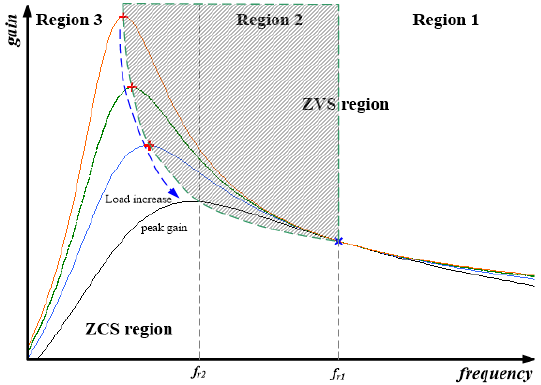
Figure 7. DC gain characteristics under load variations.